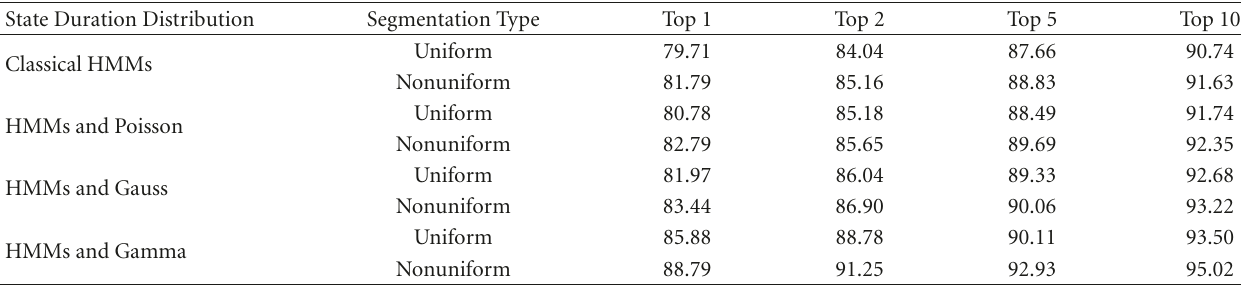
Table 2: Mean recognition results using each time 3 datasets for training and one data set for testing, and an analytical word model training method .